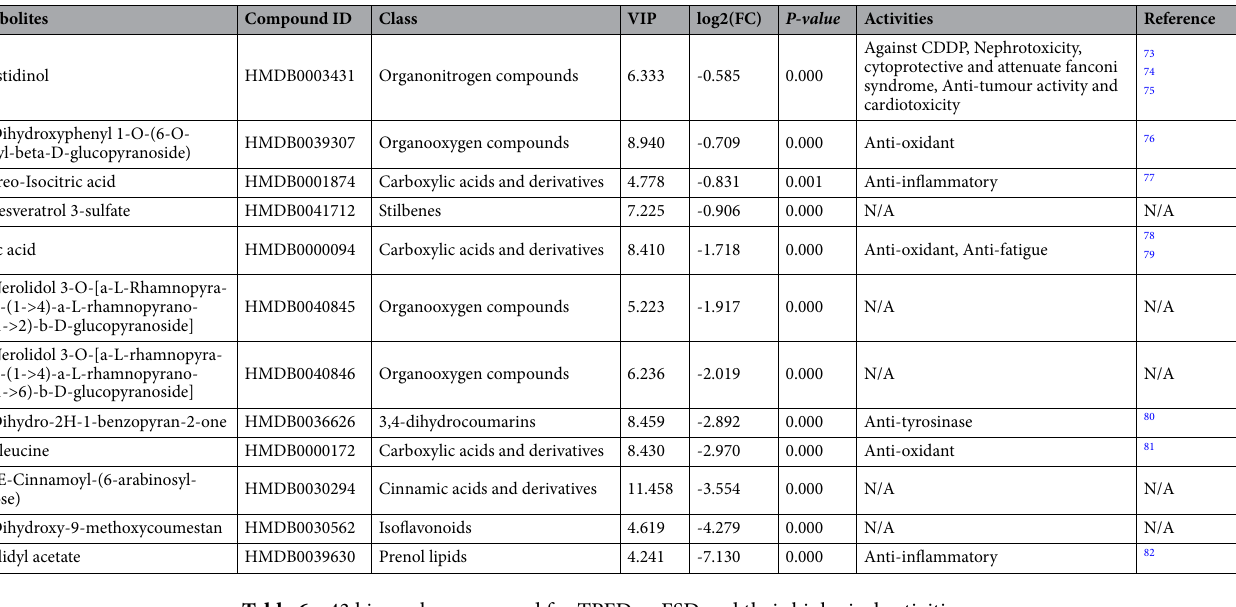
Table 6. 43 biomarkers screened for TPFD vs FSD and their biological